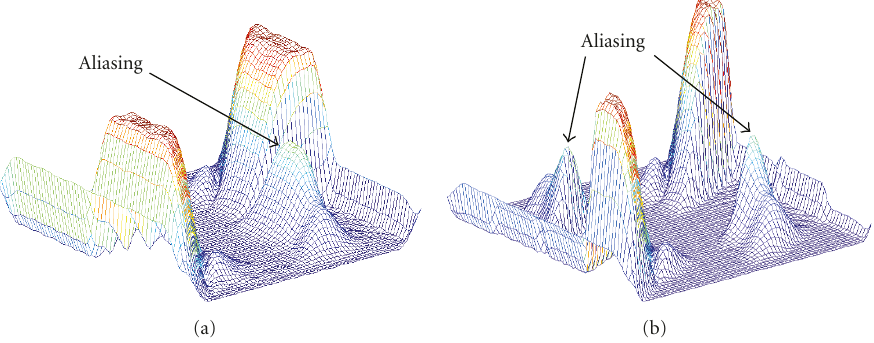
Figure 12: Examples of equivalent directional filters in the PDFB (a) the equivalent filter (cid:16) H 1 ( ω 1 , ω 2 ) of four-band PDFB, (b) a directional filter of eight-band PDFB, function associated with filter (cid:16) H 1 ( z